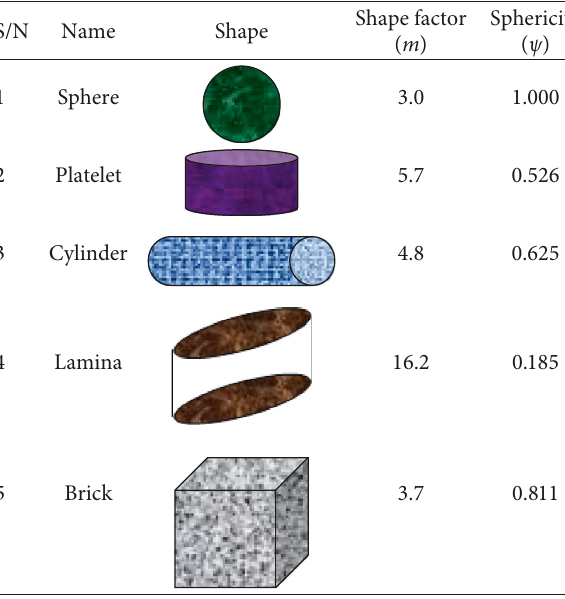
Table 1: The values of different shapes of nanoparticles [41, 66].